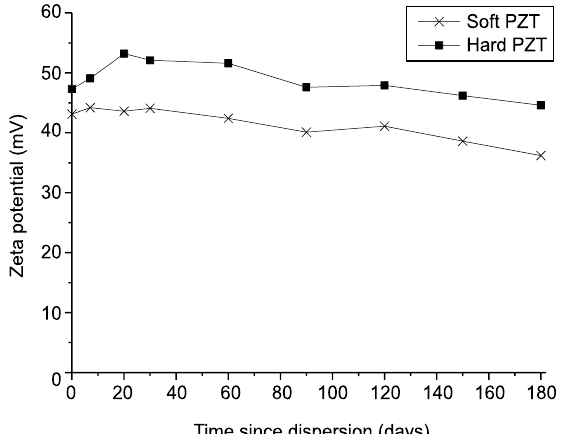
Figure 9. Zeta potential values of TiO 2 colloids over time after dispersion using both PZT transducers (1 wt.%).